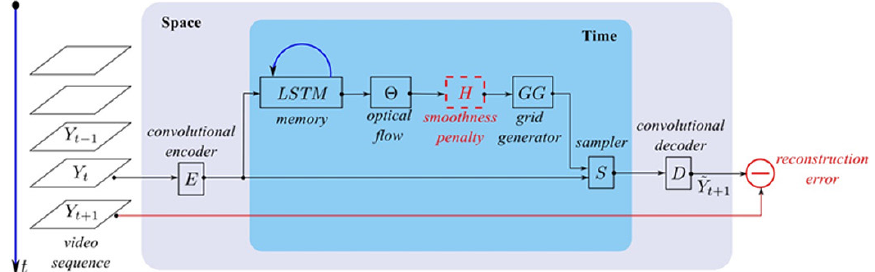
Fig. 4. The spatio-temporal video autoencoder model with its components that are separated by the space and time domain